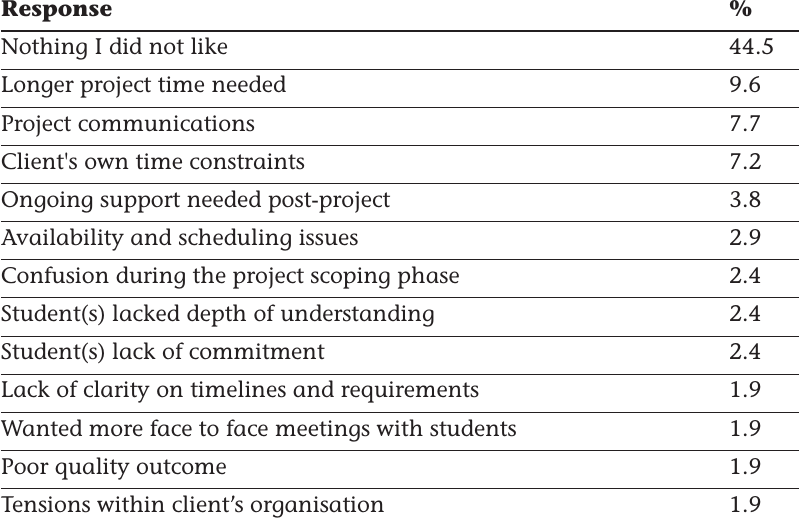
Table 7: Top 13 responses to what the community client liked least about their project, 2006 to